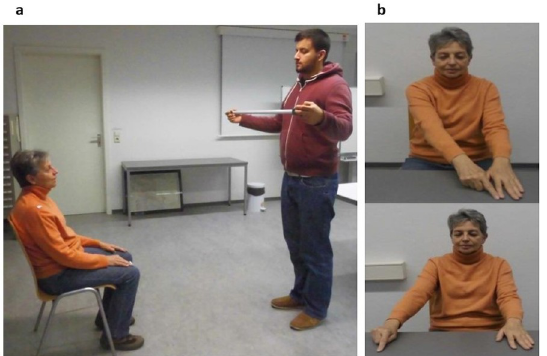
Fig 2. ( a ) Experiment 1 (Arm length estimate−Visual approach) : Participants estimate the length of their right/left arm. Arm (plus hand) length was estimated by the participant by having the experimenter adjust a horizontally oriented, retractable tape measure, so that the tape matched the perceived length of the participant’s arm (plus hand). The length of the tape was increased/decreased until its length matched the participant’s perception of his/her arm (plus hand) length. ( b ) Experiment 2 (Arm length estimate−Tactile/proprioceptive approach) : Participants seated with eyes closed while estimating the length of their right/left arm (plus hand) on the table by using a tactile starting point.